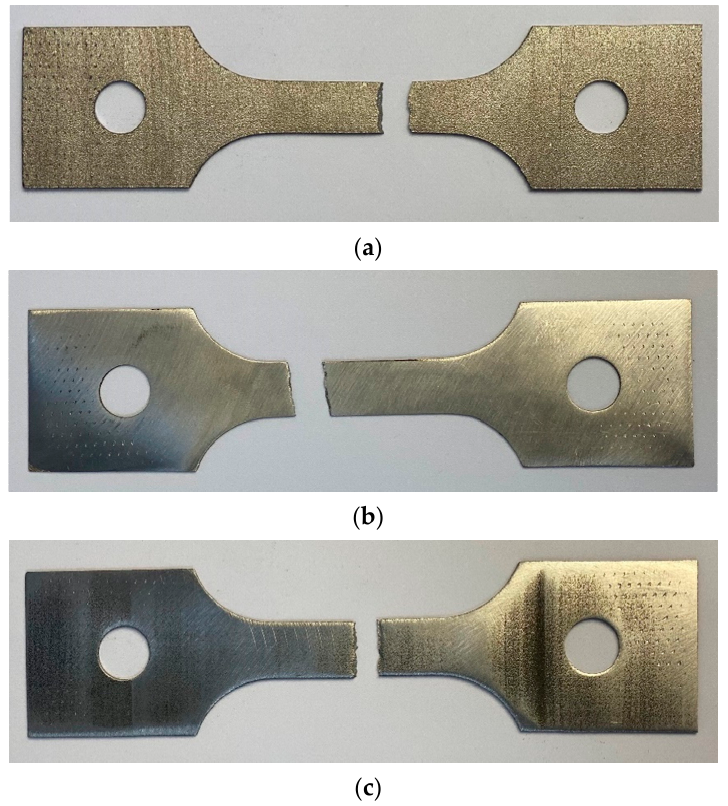
Figure 6. Photographs of the samples after the test. ( a )—sample without thermal treatment; ( b )—sample after type 1 thermal treatment; ( c )—sample after type 2 thermal treatment.